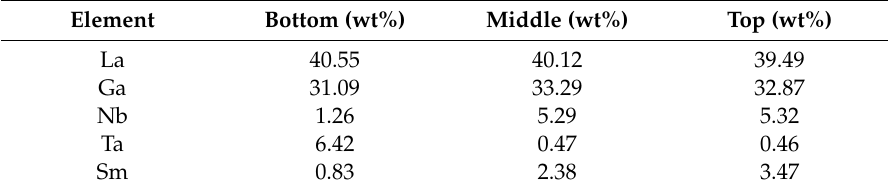
Table 2. The XRF results of the 10 at% Sm:LGN